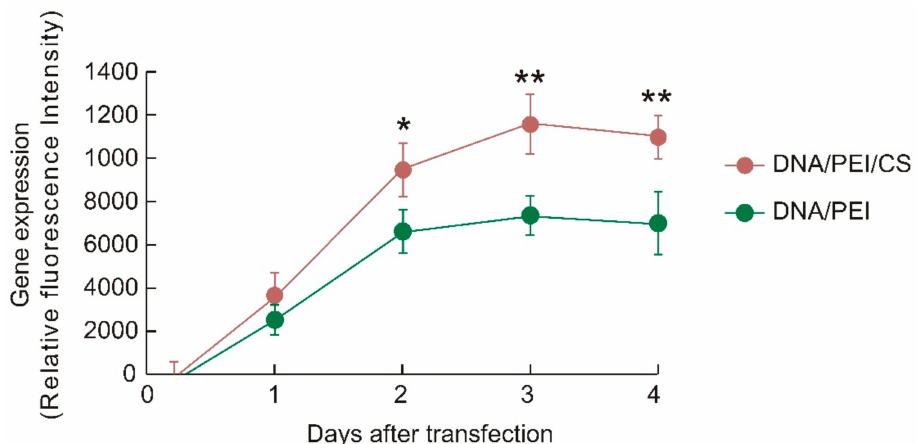
Figure 3. Gene expression efficiency in the cells transfected by the complex of pDNA coding for green fluorescent protein (GFP). The B16 melanoma cells were treated with pDNA(GFP)/PEI binary complex, or pDNA(GFP)/PEI/CS ternary complex. The fluorescence intensity of the wells was monitored for 4 days after transfection to evaluate the gene expression efficiency ( n = 3, mean ± SD, * p < 0.05 and ** p < 0.01).